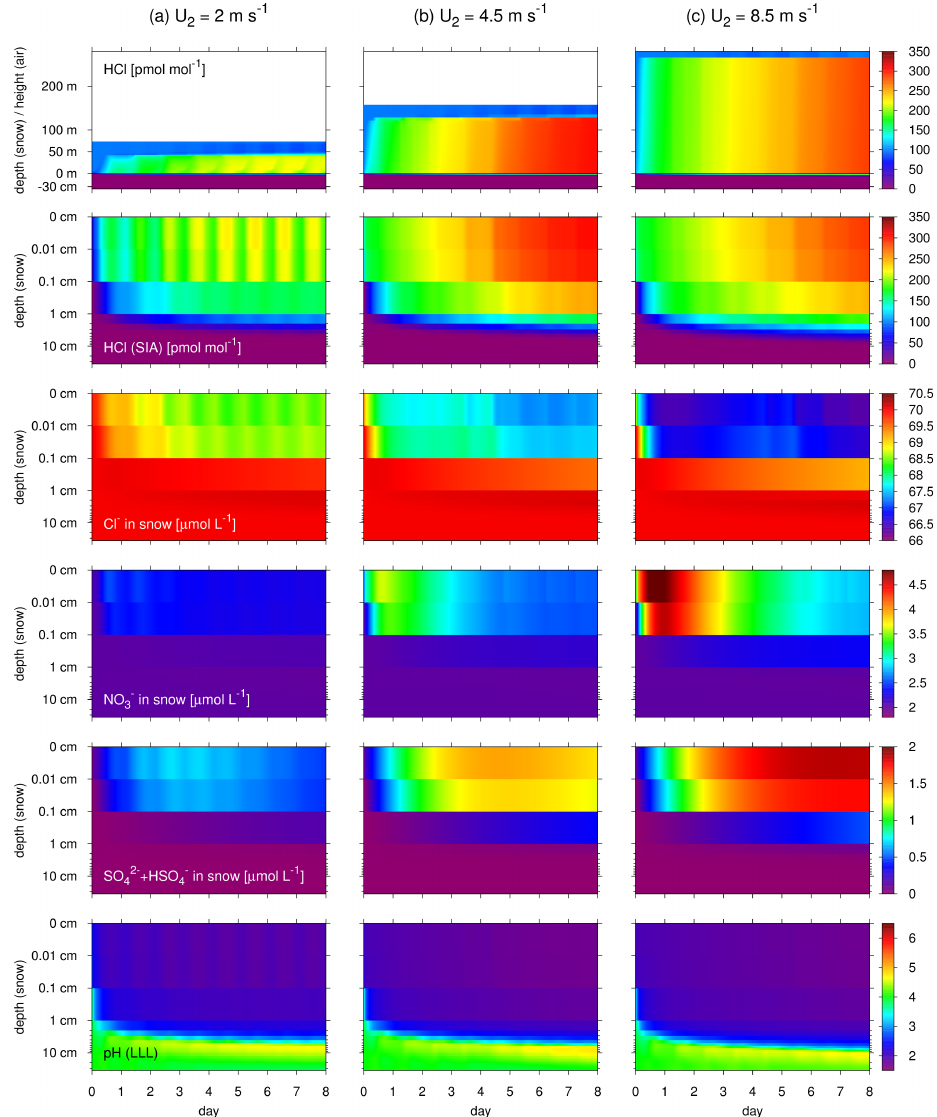
Fig. 11. Time-height cross sections for the mixing ratios of HCl (top row for the entire model domain from the bottom of the SIA and to the top of the atmosphere and second row for the SIA only), bulk concentrations of chloride (Cl − , third row), nitrate (NO − sulfate (SO 2 − +HSO − , fifth row) in snowpack grains, and pH in the LLL on the surface of snowpack grains (bottom row) from model runs 4 4 with U 2 = 2.0ms − 1 (a) , 4.5ms − 1 (b) , and 8.5ms − 1 (c)